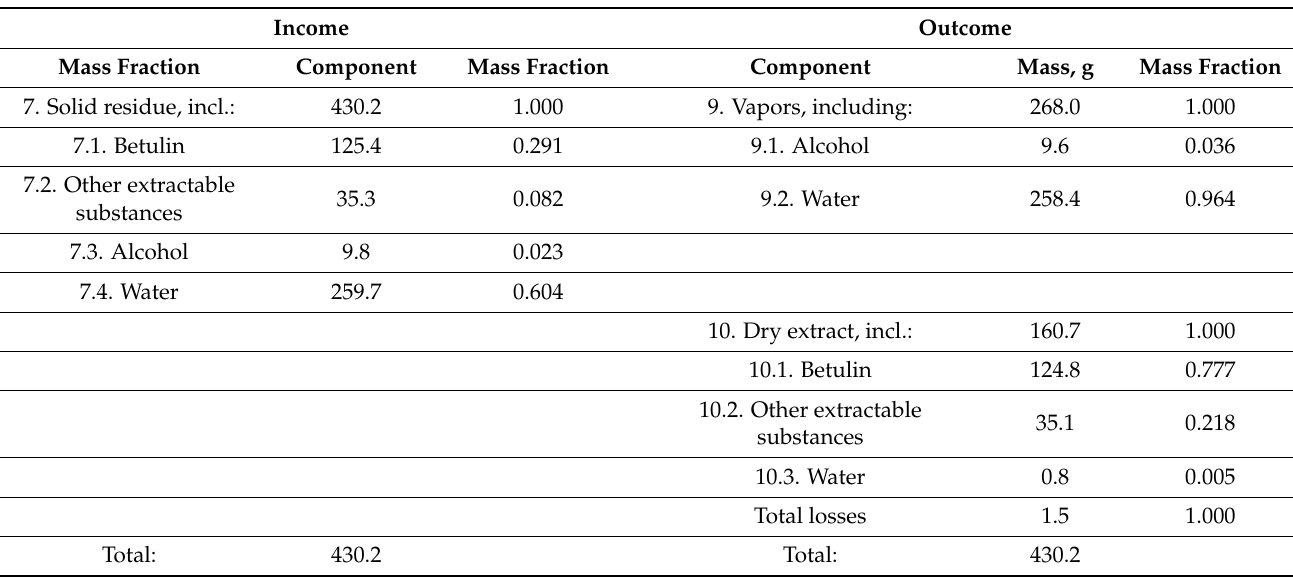
Table 6. Material balance of the extract drying process.